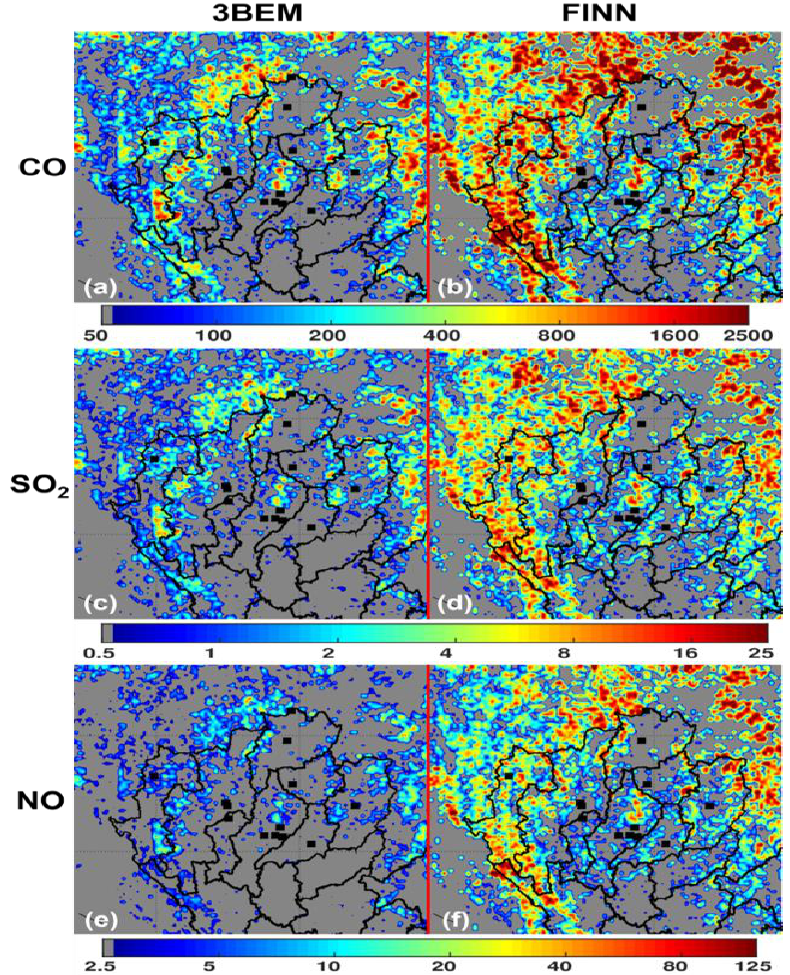
Figure 16. Comparisons of daily total 3BEM ( a , c , e ) and FINN ( b , d , f ) emissions (kg m − 2 day − 1 ) over the study area averaged over 31 days in March 2014. Top to bottom rows: CO, SO 2 , and NO emissions, respectively. Black squares in each sub-figure show locations of ground stations employed in this study.